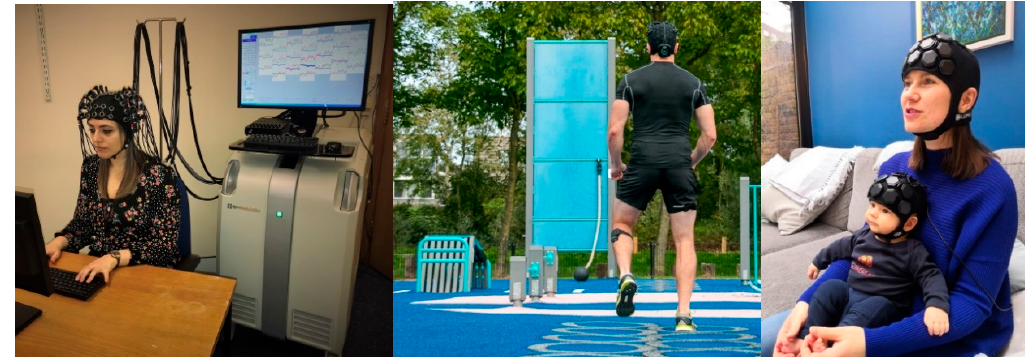
Figure 3. Continuous wave (CW) multispectral fNIRS instrumentations. Left panel: Stationary system in a conventional laboratory setting (LABNIRS, Shimadzu, Japan with three wavelengths and 52 channels) (year of release in USA 2015) (Photo courtesy of University College London, Department of Medical Physics and Biomedical Engineering). Central panel: Mobile wireless system in outdoor environment (Brite 24 , Artinis Medical Systems, The Netherlands with two wavelengths and 24 channels) (year of release 2018) (Photo courtesy of Artinis). Right panel: Mobile wireless system (LUMO, Gowerlabs Ltd., UK) (year of release 2019) (Photo courtesy of Gowerlabs). The first commercially available modular, wearable, high-density di ff use optical tomography (DOT) system consisting of a series of hexagonal sensor modules (‘tiles’), each of which provides two wavelength LED sources and four detectors. Channels are formed both within and across tiles with source–detector separations ranging from 10 to 40 mm. By connecting multiple tiles into the LUMO head cap, users can create lightweight, high-density fNIRS imaging arrays to cover any part of the cortex. We obtained permission from photographed subjects.